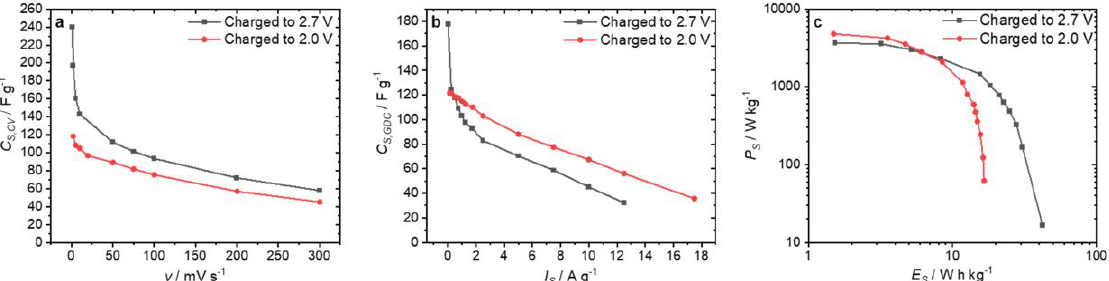
Figure 6. Electrochemical measurements on the ACF, which was activated twice (CO 2 and H 2 O): C S,CV at different scan rates ν ( a ), C S,GDC at different current densities I S per electrode ( b ), and Ragone plot calculated from GDC for the whole device ( c ). The values in black were obtained for charging the EDLC to 2.7 V, and those in red for charging to 2.0